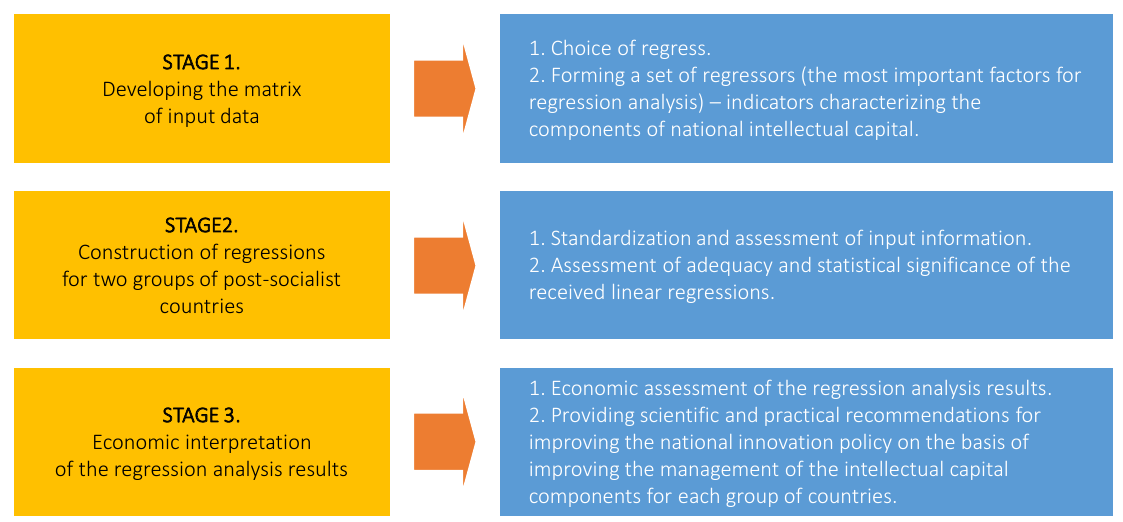
Figure 1. Stages of the study of innovation levers for developing the intellectual basis of countries’ economic